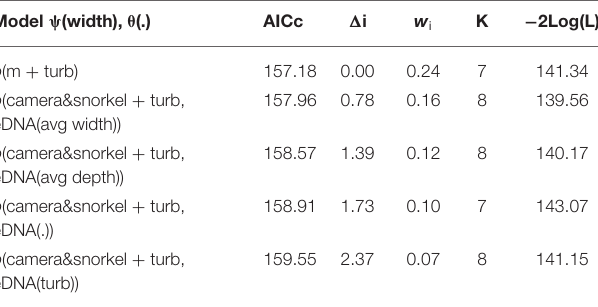
TABLE 3 | Summary of the model selection using AIC for the occupancy and detection probability of Cape Kuper using underwater cameras, snorkel surveys, and combined